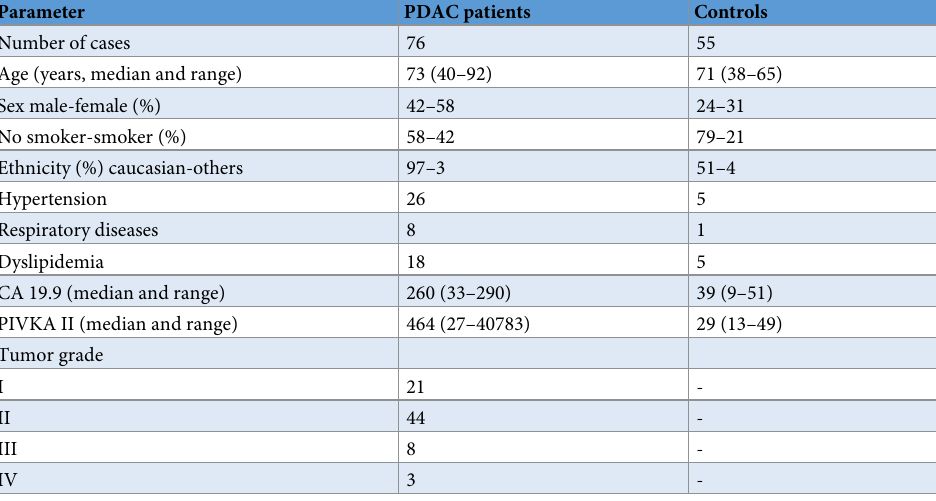
Table 1. Demographics and clinical characteristics of PDAC study cohort and